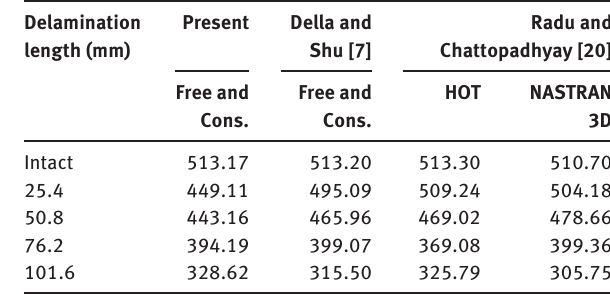
Table 5 Fundamental frequencies (Hz) of the LCB with central delamination located at interface